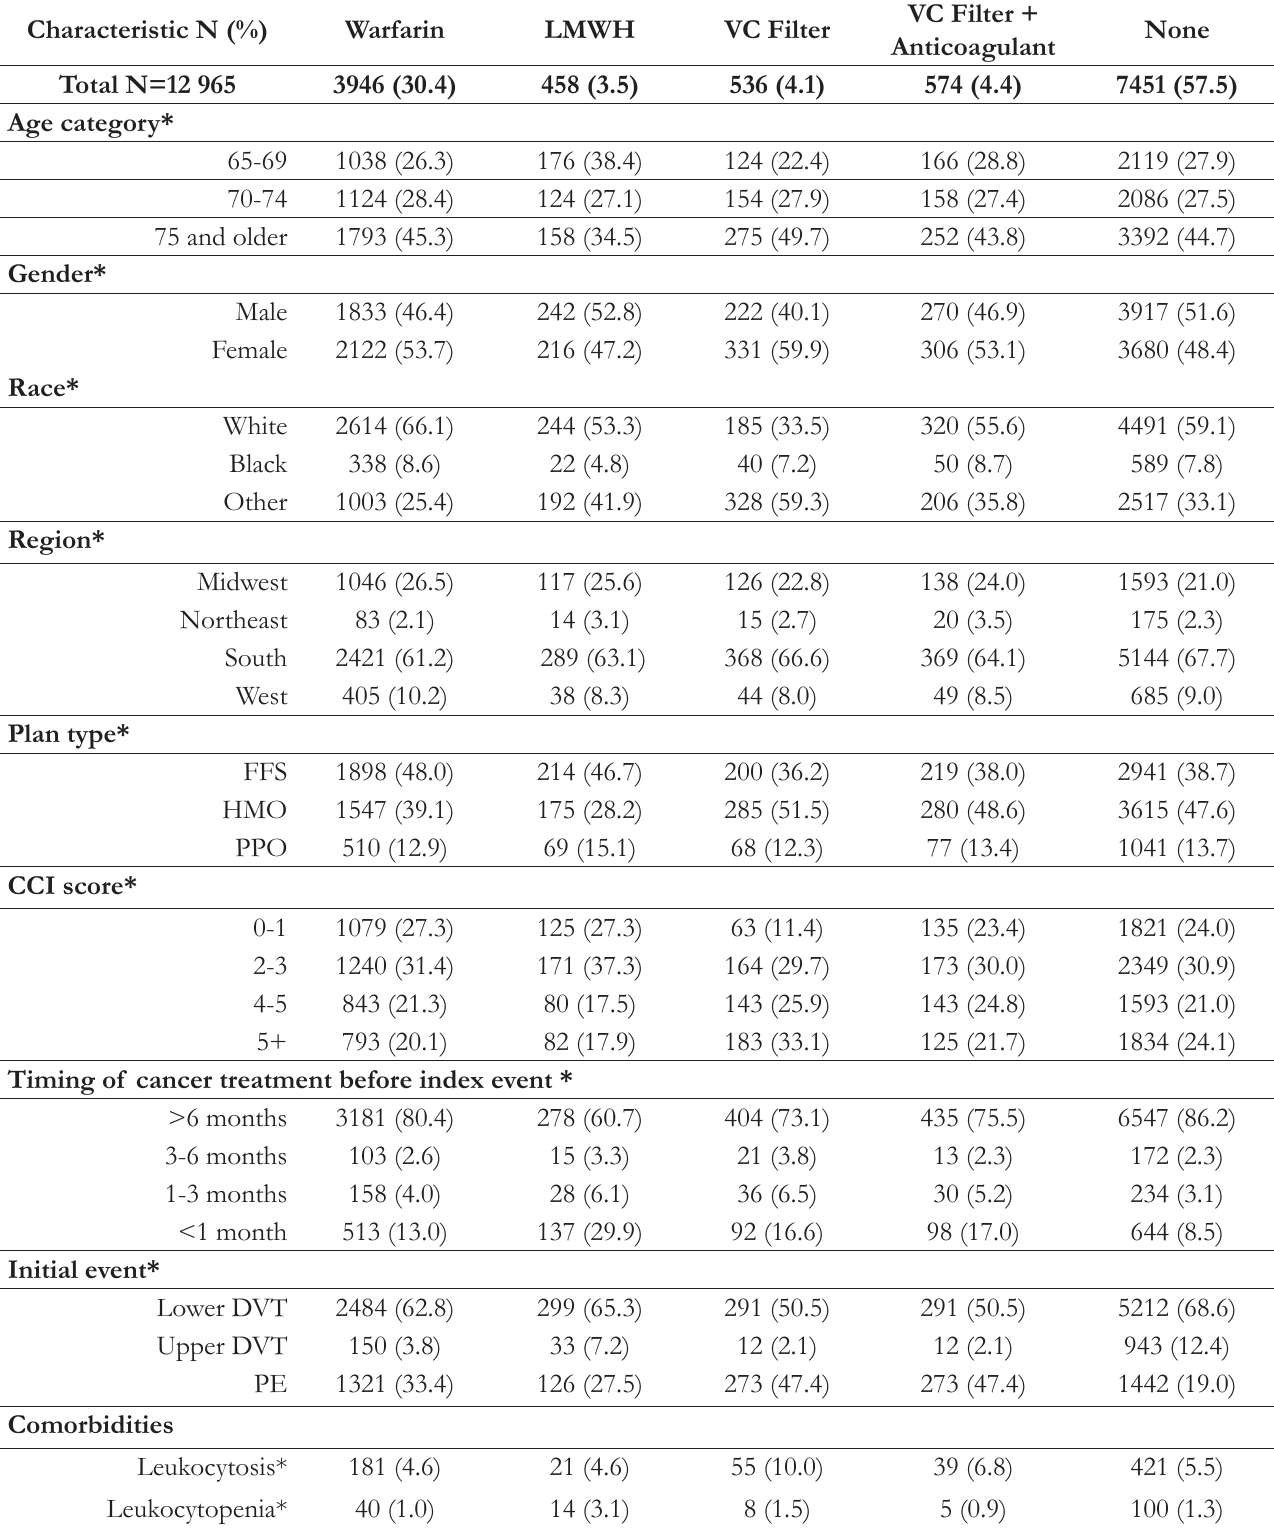
Table 1. Baseline Demographic and Clinical Characteristics by Treatment Group Characteristic N